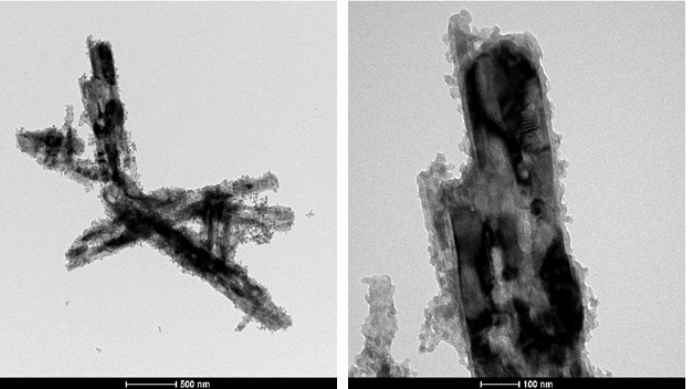
Figure 8. TEM images of V5 1.7 _12h sample (the black rod-like structures) functionalized with a SiO 2 layer (the grey globular layer).